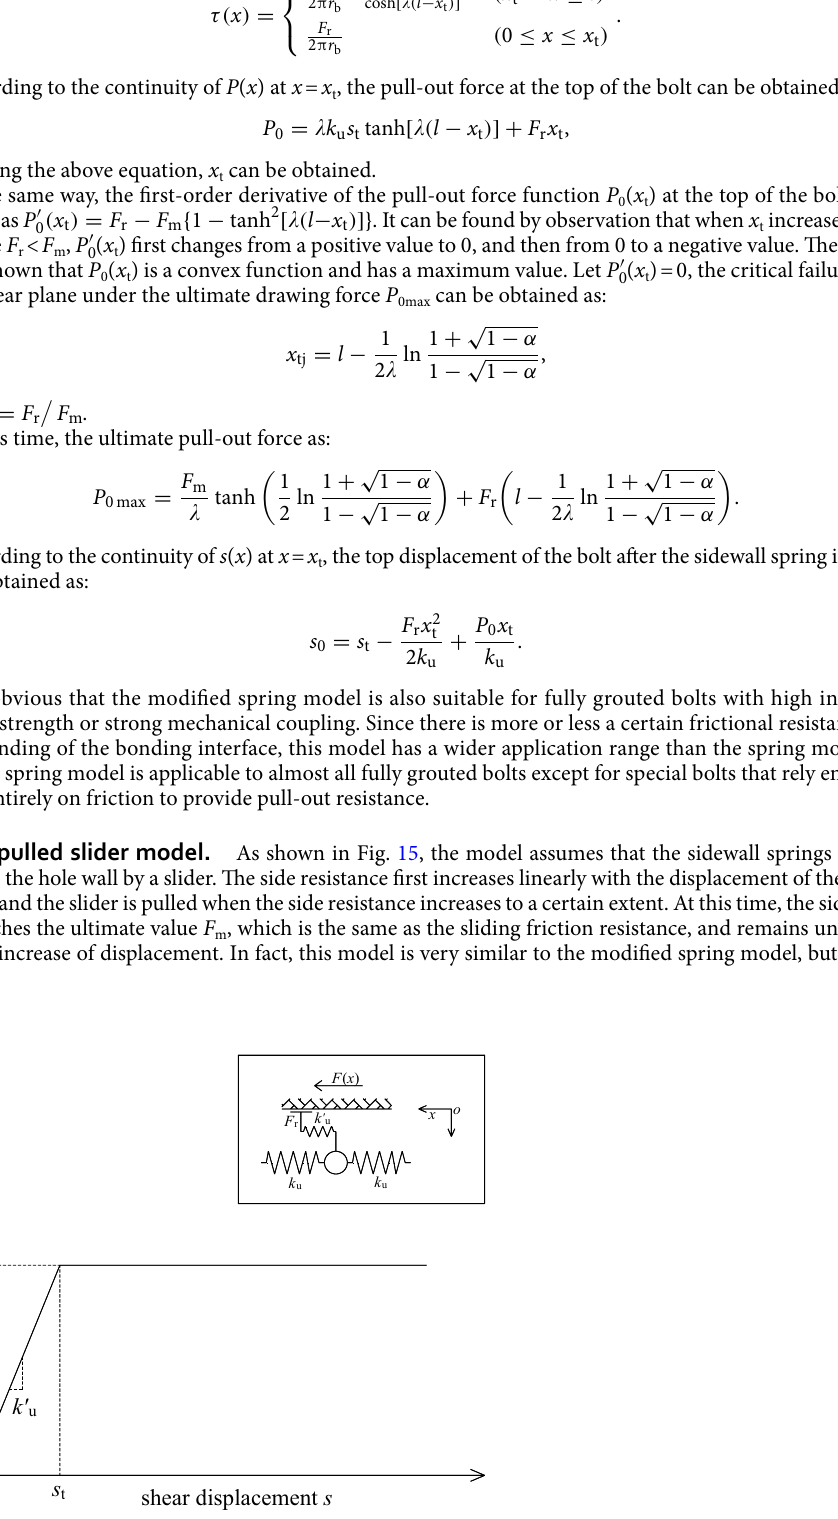
Figure 15. Schematic diagram of spring-pulled slider